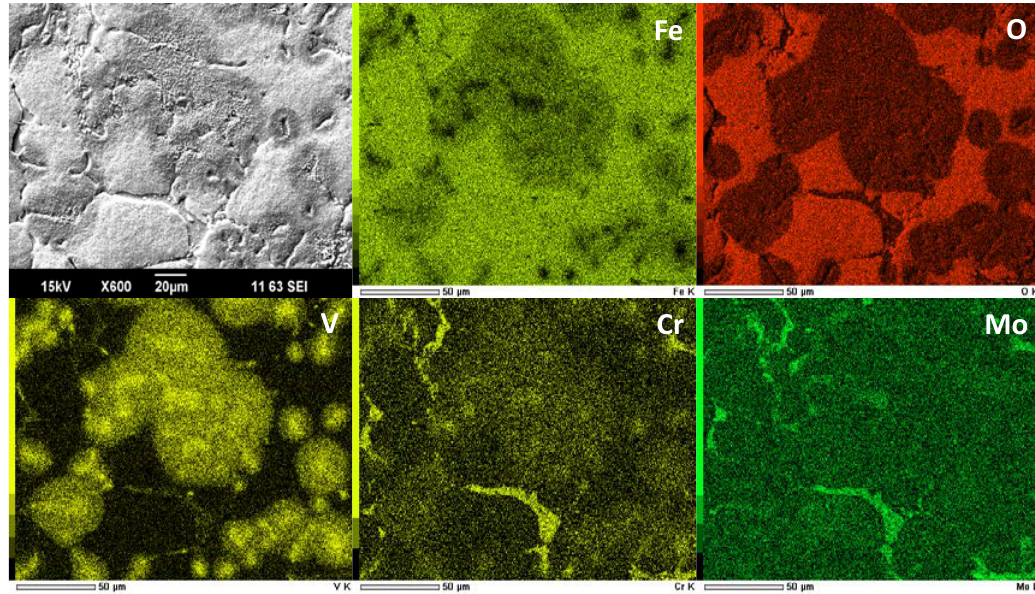
Figure 4. SEM X-ray maps of the HSS oxidized at 700 °C in dry air.